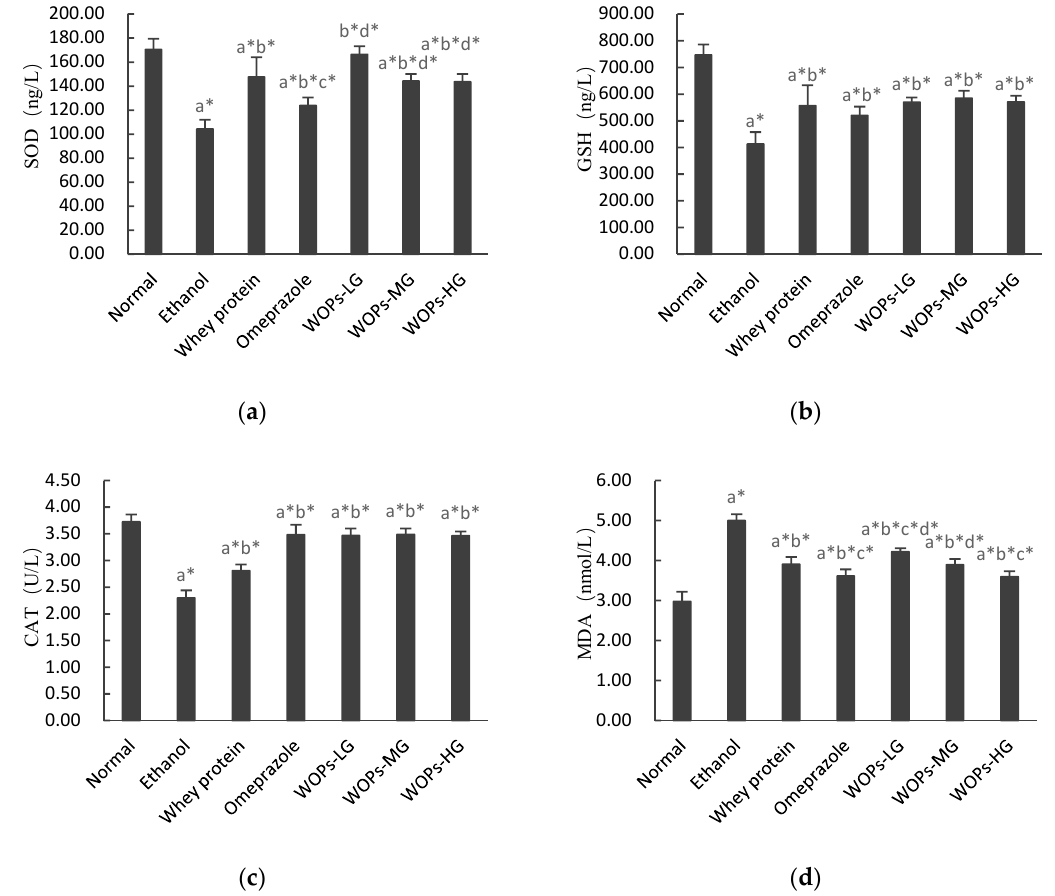
Figure 3. Effects of WOPs on SOD ( a ), GSH ( b ), CAT ( c ), MDA ( d ) levels in ethanol-induced rats. Values are presented as mean ± SD ( n = 10); a, b, c, d means compared with normal group, ethanol group, whey protein group, and omeprazole group separately; * p < 0.05 was considered to have statistical differences. SOD, superoxide dismutase; GSH, reduced glutathione; CAT, Catalase; MDA, malondialdehyde; WOPs-LG, 220 mg/kg of walnut oligopeptides group; WOPs-MG, 440 mg/kg of walnut oligopeptides group; WOPs-HG, 880 mg/kg of walnut oligopeptides group.